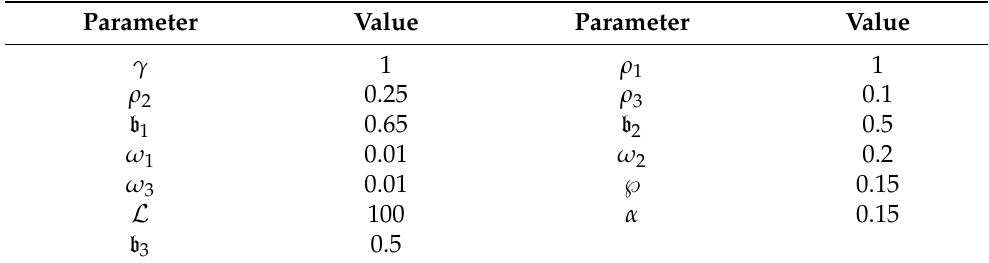
Table 1. The parameters and their description of the model